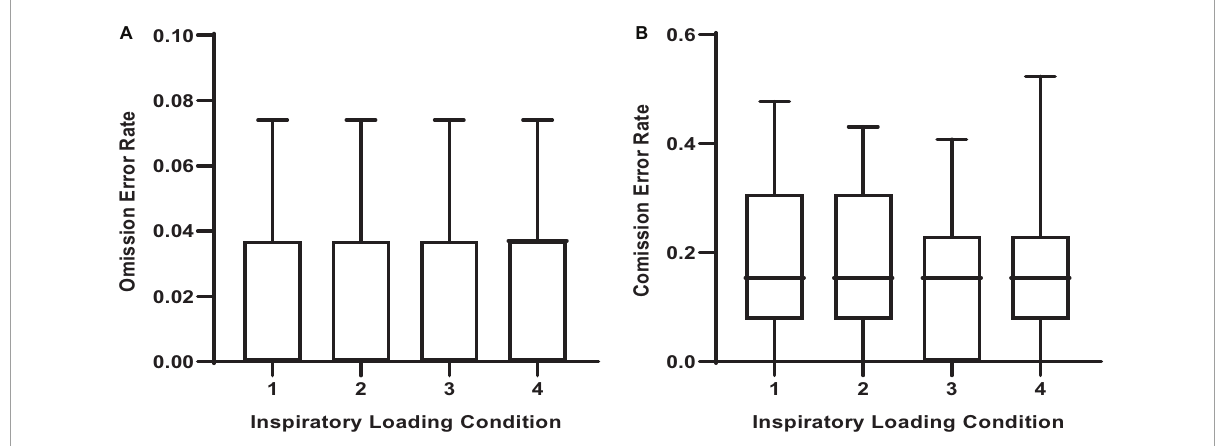
FIGURE5 Error rates across inspiratory threshold loading conditions during masked conjunctive continuous performance trials. (A) Depicts the differences in omission error rates across loading conditions. (B) Depicts the differences in commission error rates across loading conditions. The upper and lower limits of the box represent the 95% CI, the horizontal line in the box represents the mean, and the whiskers represent the SEM. There were no differences in error rates between loading conditions.